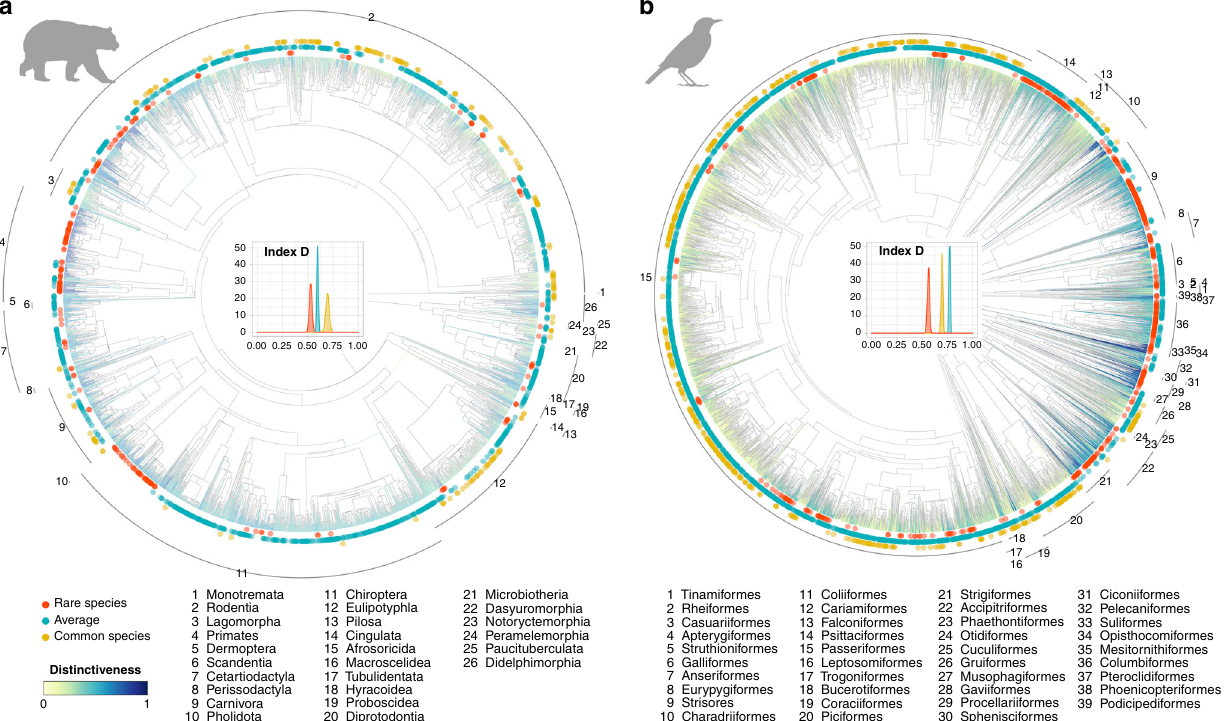
Fig. 3 Closely related species were not necessarily more similar in their degree of ecological rarity than distantly related species but ecological rarity is over-represented in some orders: Primate and Chiropotera for mammals and Psittaciformes, Caprimulgiformes, and Apodiformes (Strisores) for birds. a , b Phylogenies of terrestrial mammals and birds. Functional distinctiveness values are represented on terminal branches (color gradient). Ecologically rare species are highlighted by red dots, common by orange and average by blue. Distribution of the values of phylogenetic signal of ecological rarities (index D) computed on 100 trees are plotted in the center of the tree. Orders names are indicated on the outside arcs. The fi gure represents a single phylogeny from the 100 phylogenies generated (see “ Methods ” ). Icons were generated using R ( rphylopic package) and are under the Public Domain Dedication 1.0